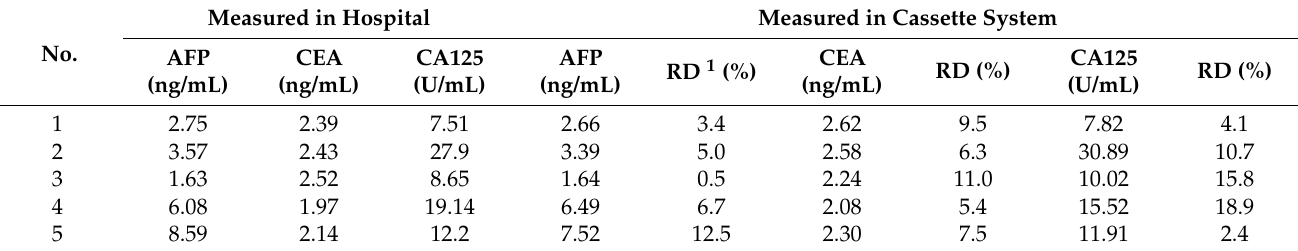
Table 2. Detection of five clinical